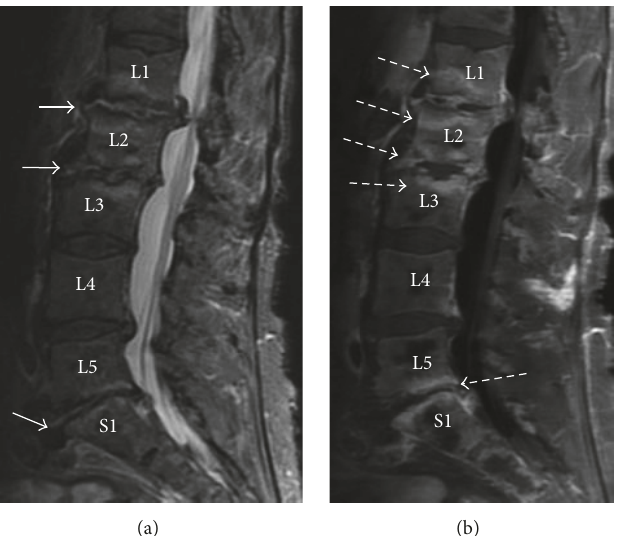
Figure 1: Prevertebral osteomyelitis, discitis, and soft-tissue abscess seen on sagittal MRI imaging with and without contrast . (a) Sagittal T2 STIR showing high signal consistent with fluid in the L1-2, L2-3, and L5-S1 disc spaces with endplate edema (white arrows). (b) Sagittal T1 fat saturation obtained after contrast shows extensive enhancement centered around the L1–3 and L5-S1 disc spaces consistent with discitis and osteomyelitis (dashed